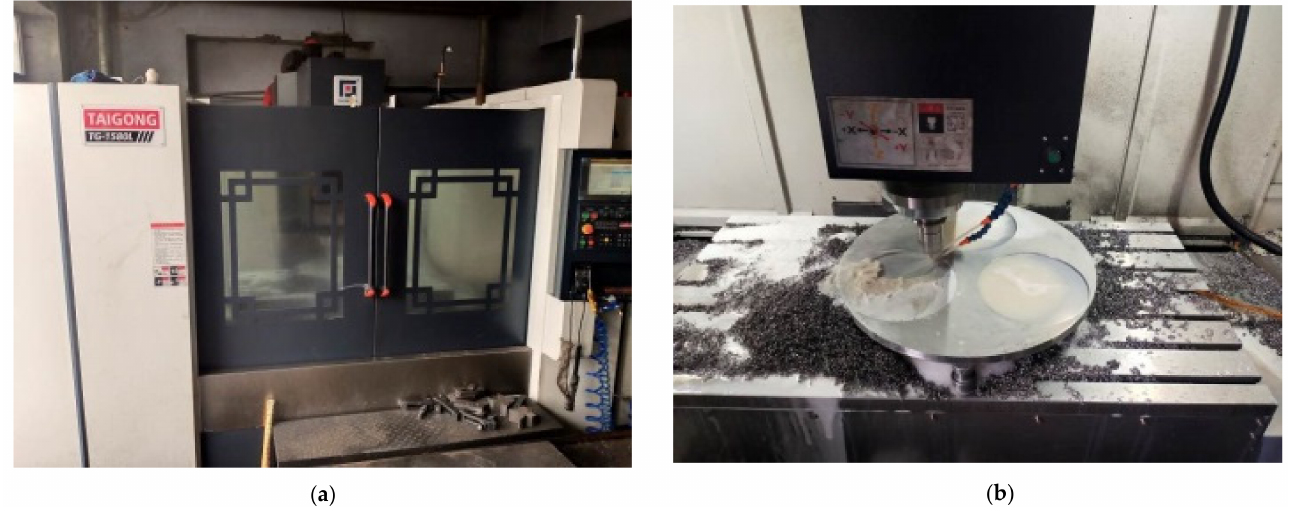
Figure 13. ( a ) VMC-series machine tools and ( b ) support plate processing.